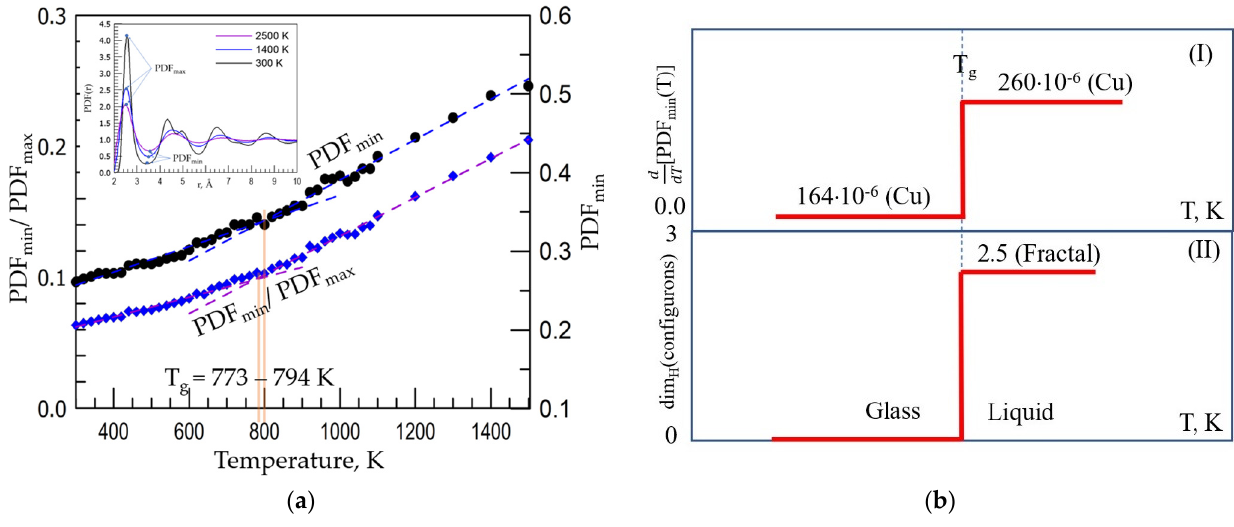
Figure 4. ( a ) The values of pair distribution function first minimum PDFmin of Cu following the method proposed in [18] and ratios of PDF min /PDF max after Wendt–Abraham criterion [38] as a function of temperature where the inset shows the definitions of parameters used with PDF(r) given for three temperatures T = 2500, 1400, and 300 K respectively. ( b ) The prominent changes at the Cu glass transition temperature T g = 794 ± 10 K of FSDM (I) and Hausdorff–Besicovitch dimension of configurons phase dim H (configurons) (II).